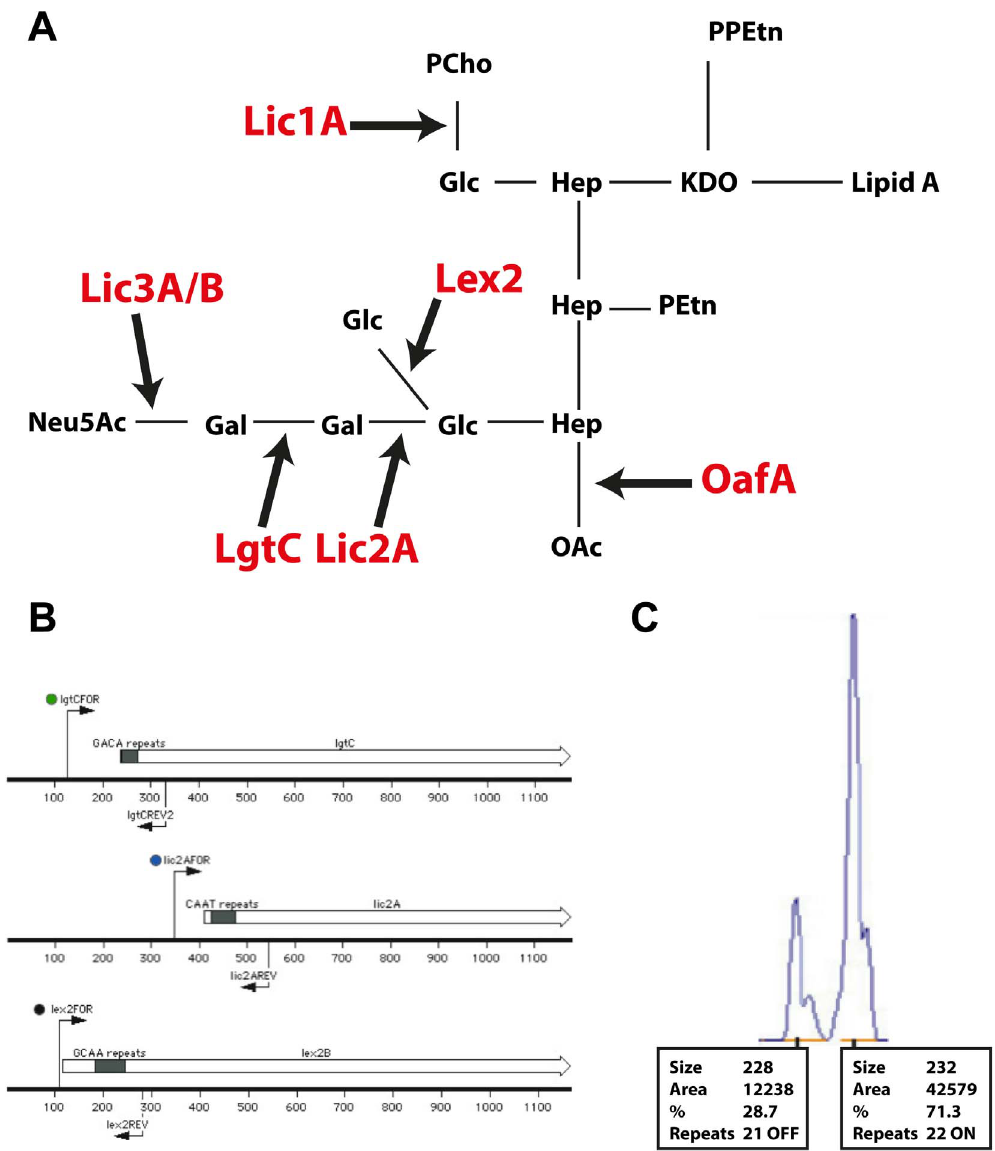
Figure 1. LOS biosynthesis pathway in Haemophilusinfluenzae , and examples of multiplex PCR and fragment analysis traces. ( A ) an illustration of the roles of the proteins encoded by the seven phasevariable genes studied in this work: Lic1=phosphocholine transferase; Lic2A=galactosyltransferase; Lic3A and Lic3B=analogous sialyltransferases; Lex2=glucosyltransferase; OafA=O-acetylase; LgtC=galactosyltransfer- ase. The LOS contains 2-keto-3-deoxyoctulosonic acid (KDO); phosphoethanolamine (PEtn); pyrophosphoethanolamine (PPEtn); heptose (Hep); galactose (Gal); glucose (Glc); phosphocholine (PCho); and O-acetyl group (OAc); ( B ) an example of a multiplex PCR reaction utilized in this study using three gene specific primer pairs, with each pair containing a forward primer with a specific fluorescent label: FAM (6-carboxyflourescein), VIC, or NED; and ( C ) an example of a typical fragment analysis trace generated by a fluorescent PCR reaction separated using the Genescan system.